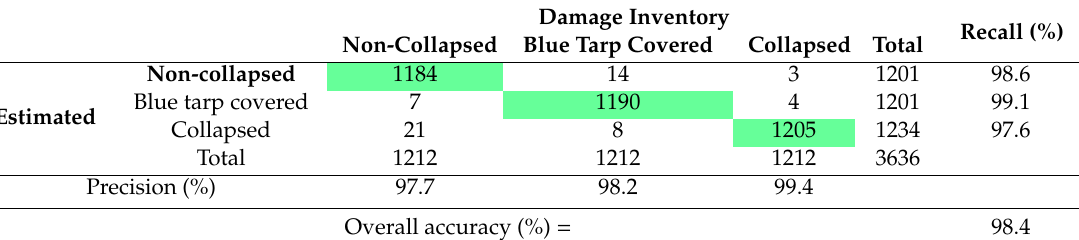
Figure 8. Convergence of the loss functions for the training and validation data. Table 6. Classification accuracy for the validation data.